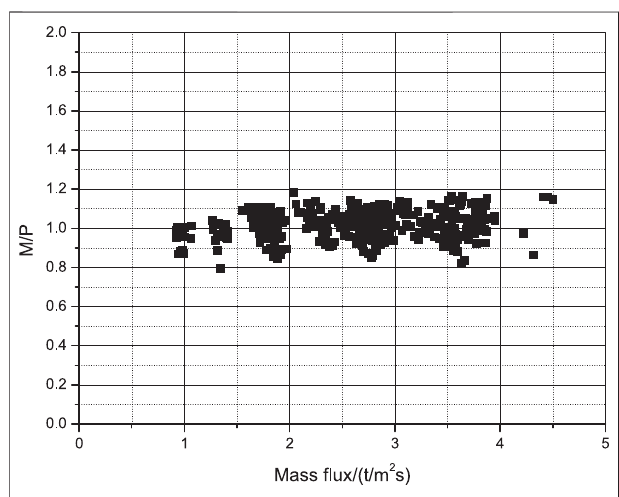
FIGURE 13 | M/P as a function of pressure.